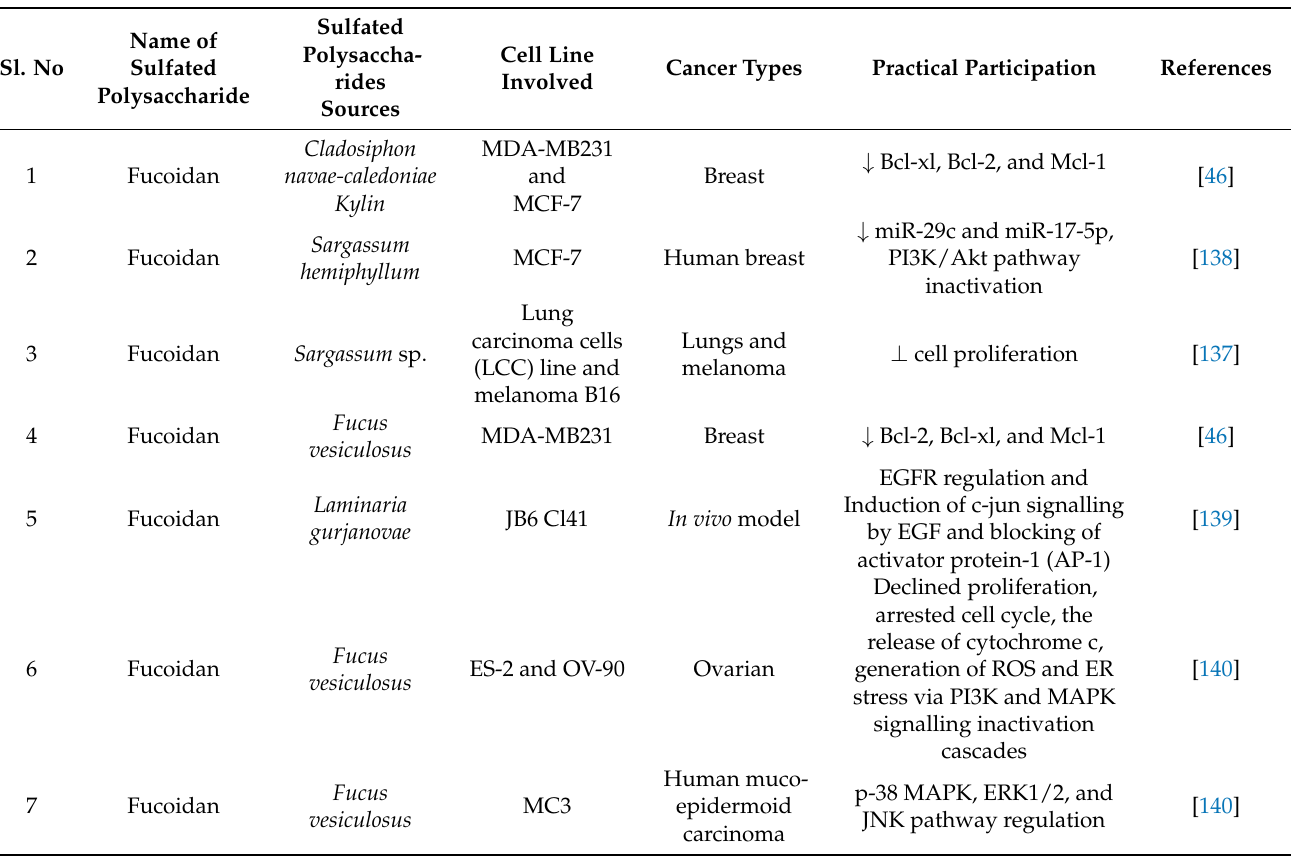
Table 2. Sulfated polysaccharides from brown algae as potent anticancer agents. ↑ : upregulation, ↓ : Downregulation, ⊥ :